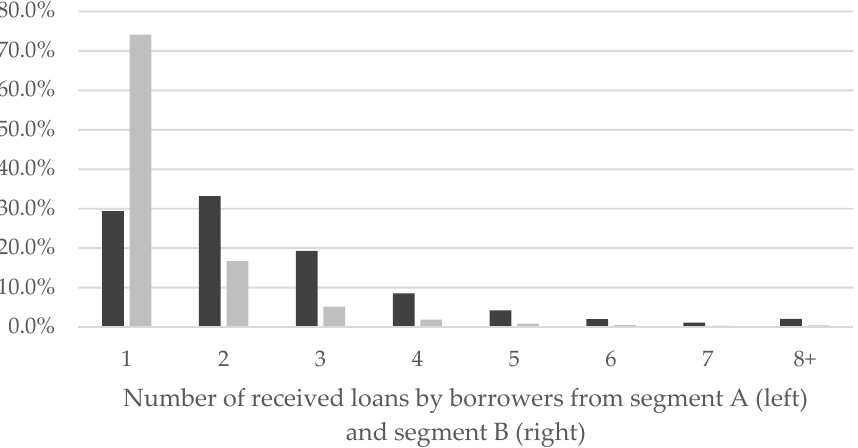
Figure 5. Comparison of recurrent loan-distribution for segments A and B.